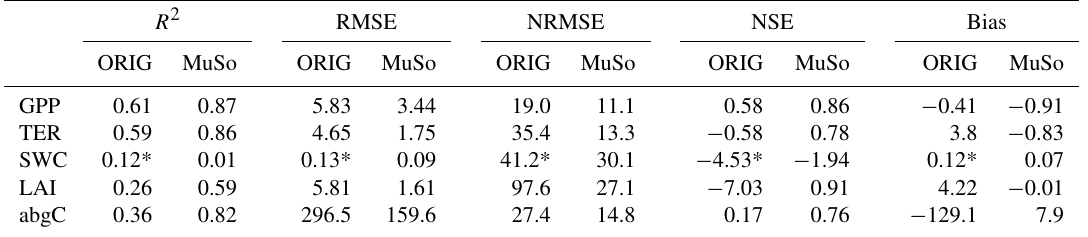
Table 3. Quantitative evaluation of the original and adjusted models at the grassland site in Bugac using different error metrics. ORIG means the original Biome-BGC, while MuSo refers to the BBGCMuSo. See text for the definitions of the error metrics. R 2 RMSE NRMSE NSE Bias ORIG MuSo ORIG MuSo ORIG MuSo ORIG MuSo ORIG MuSo GPP 0.50 0.66 5.82 1.52 51.2 13.4 LHF 0.24 0.62 1.89 0.83 33.2 14.5 − 1.51 0.52 0.01 − 0.33 SWC 0.60 ∗ 0.64 0.04 ∗ 0.09 − 0.01 ∗ 0.09